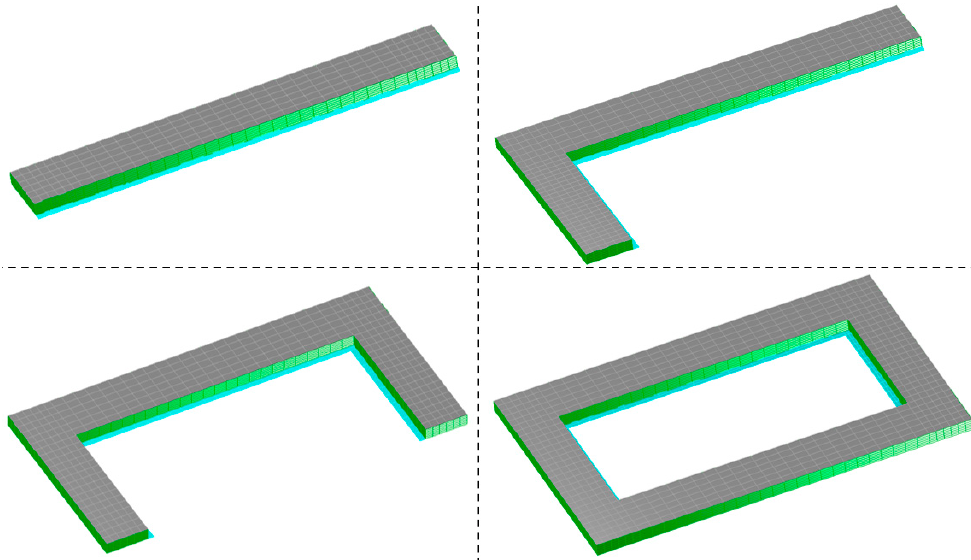
Figure 3. Patches for the numerical models of floating breakwaters of different configurations: single, L-shape, U shape, and barge frame. The light blue patches are the damping dipole plates.